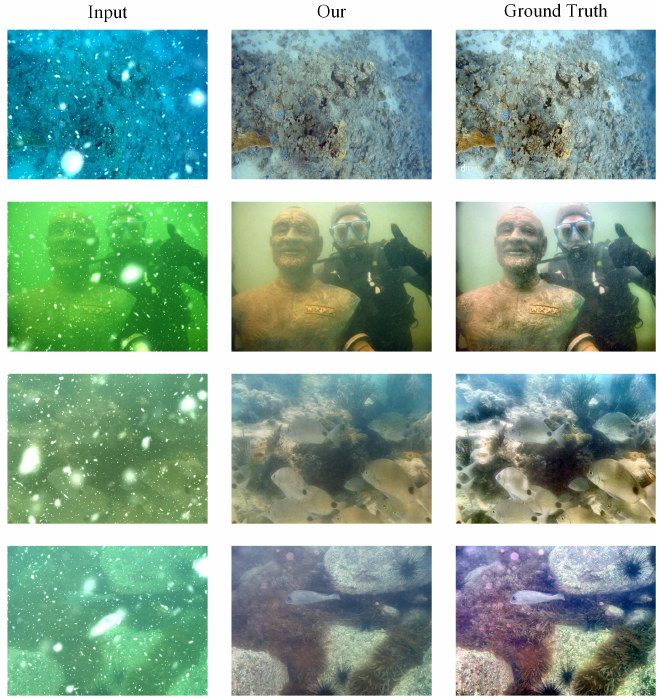
Figure 6. Image enhancement results of UIR-Net on